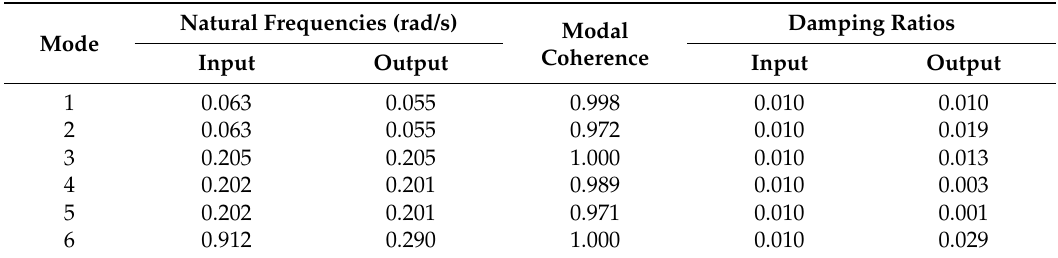
Table 6. Evaluation of FDD efficiency for the first case.